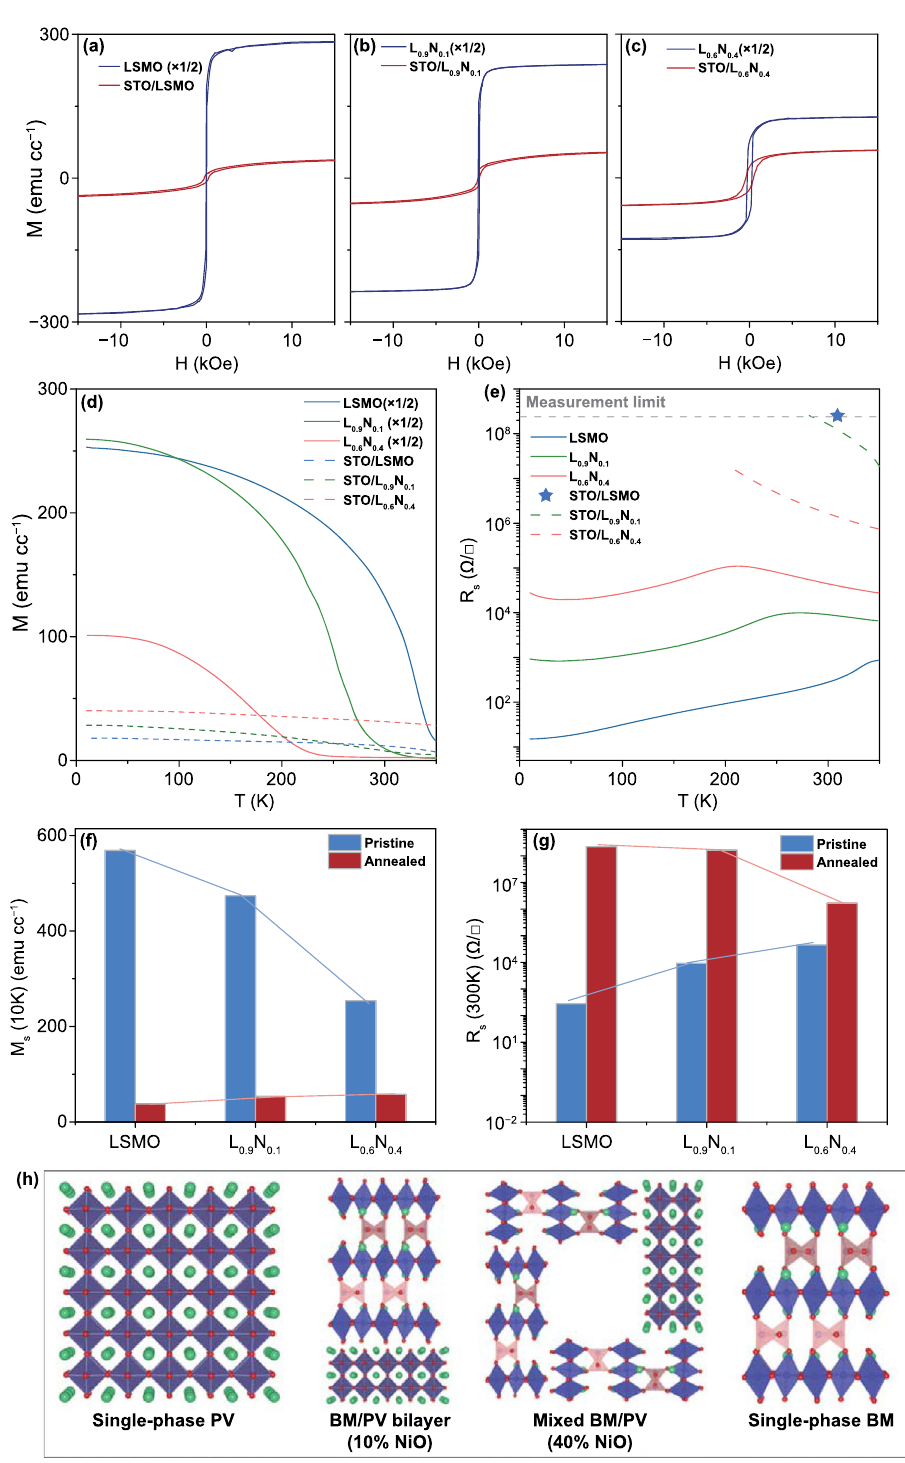
Fig. 4 a–c Magnetic hysteresis curves, d temperature-dependent field-cooled magnetization and e temperature-dependent sheet resistance of as-grown PV and vacuum-annealed BM L 1- x N x films with x = 0, x = 0.1, x = 0.4, the star designates the range for a pure LSMO-BM film The magnetization values of as-grown L 1- x N x films are presented after multiplying a factor of 1/2 for better illustration with the much smaller values of vacuum-annealed BM L 1- x N x films. f Saturation magneti- zation M s at 10 K and g film sheet resistance R s at 300 K of as-grown PV and vacuum-annealed BM L 1- x N x films as a function of the NiO ratio x . The solid lines are used as a guide to the eye to highlight the systematic magnetization and sheet resistance variation as a function of the film composition and phase evolution. h Schematic illustration of the spatial distribution of different nanostructure configurations in the nanocomposite films as a function of the nominal NiO fraction